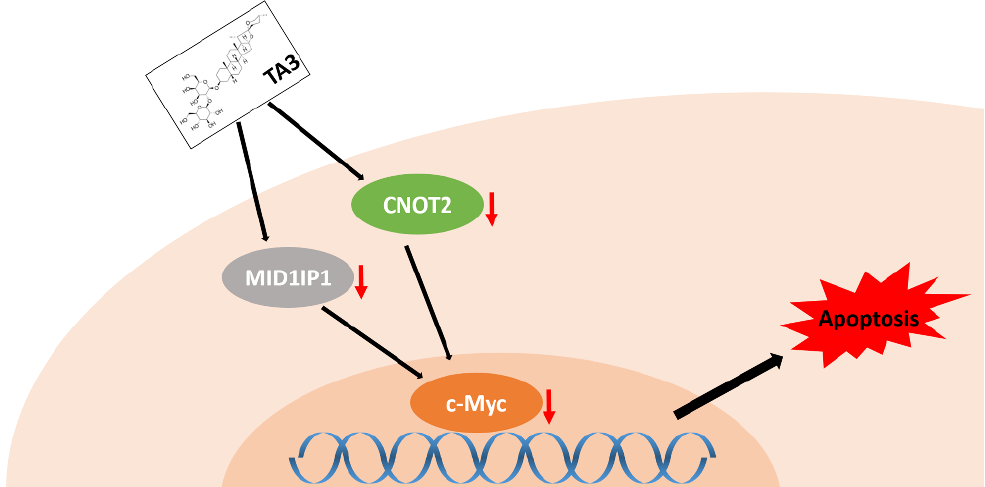
Figure 7. Mechanism of TA3 to induce apoptosis in colorectal cancer by downregulating c-Myc via CNOT2 or MID1IP1.